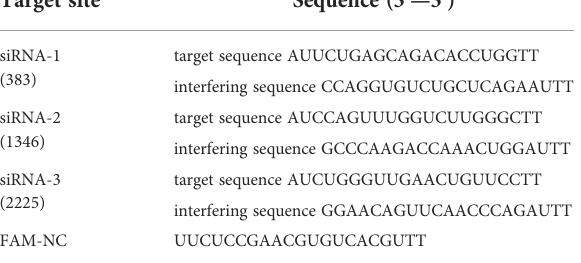
TABLE 2 siRNA target site and